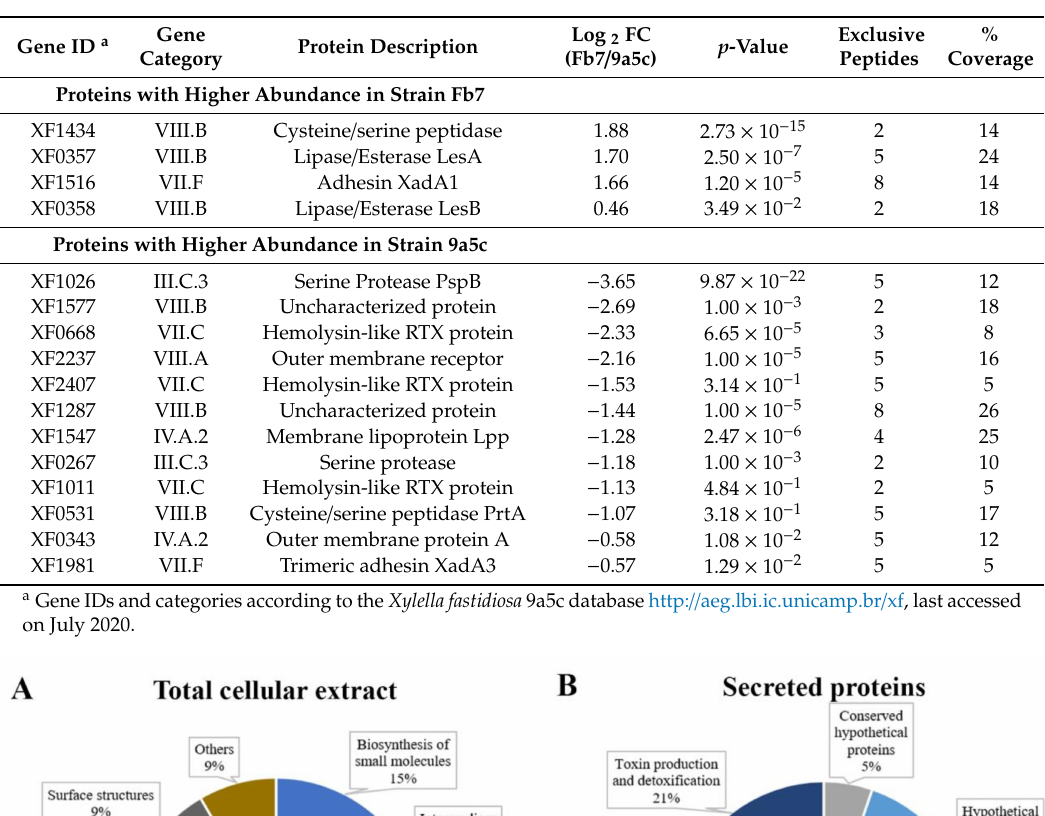
Table 3. Secreted proteins with di ff erential abundance between X. fastidiosa strains Fb7 and 9a5c.